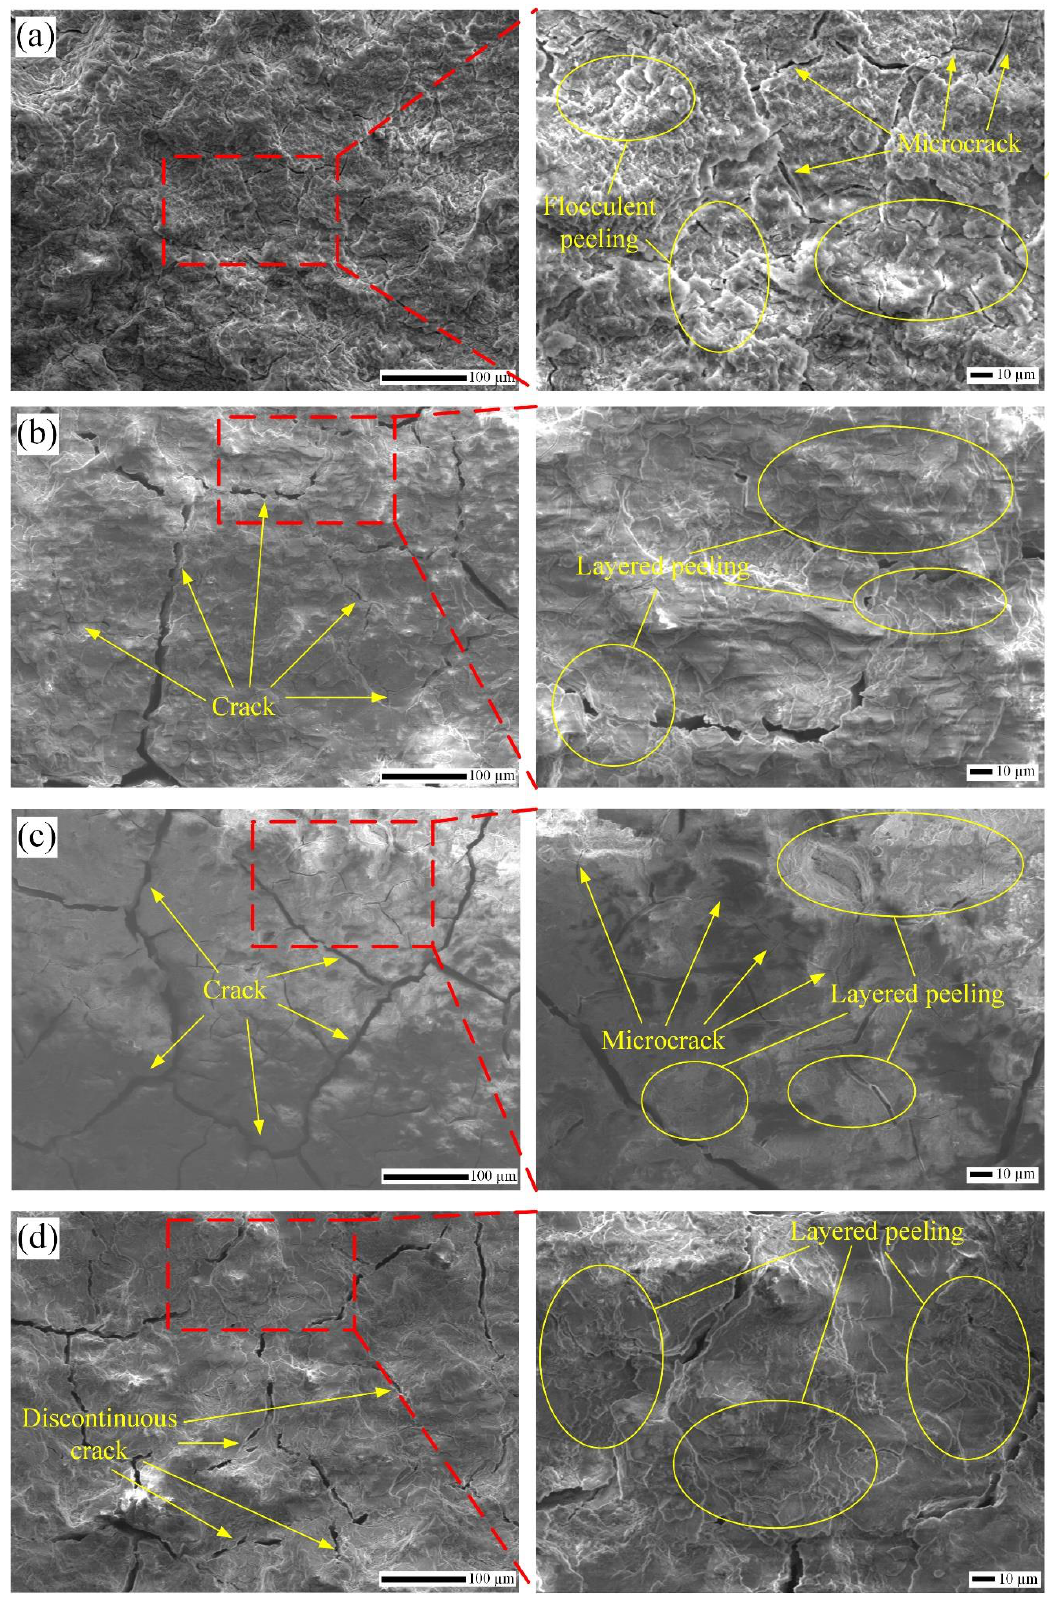
Figure 10. SEM diagram of corroded surface: ( a ) untreated; ( b ) 1.19 GW / cm 2 ; ( c ) 1.99 GW / cm 2 ; ( d ) 2.79 GW / cm 2 .